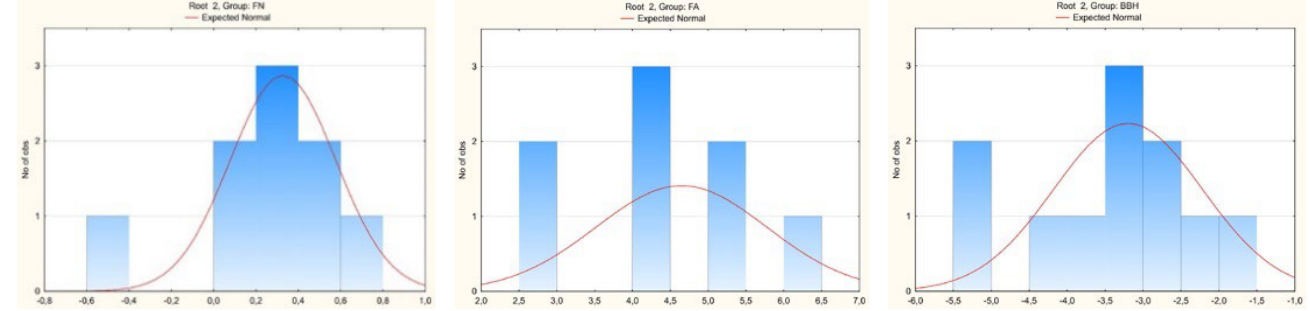
Figure 1. Normal distribution of variables within each group (Fetească neagră, Busuioacă de Bohotin and Fetească alba) .